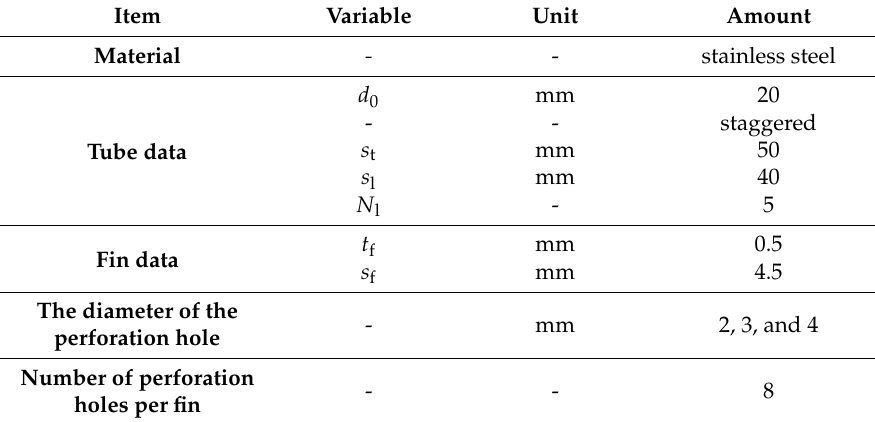
Table 1. The tube and star-shaped fin data.